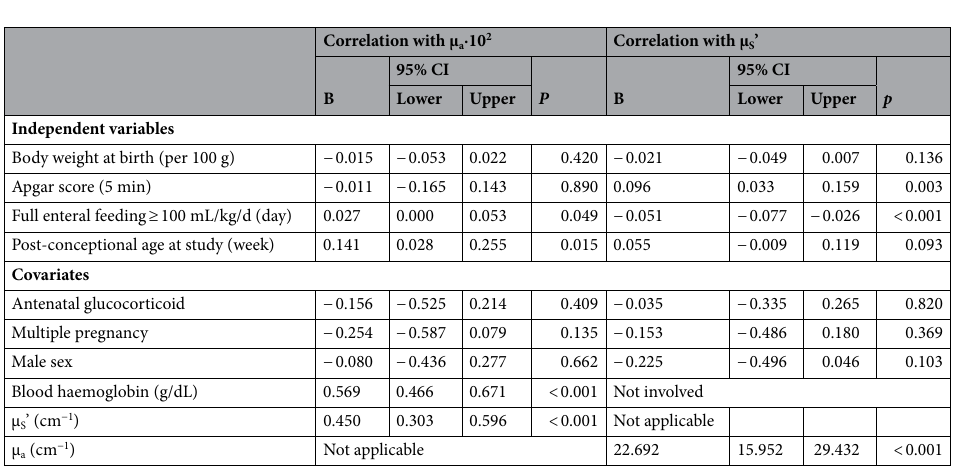
Figure 2. Dependence of μ S ’ on µ a in four head regions. Scatter plots demonstrating relationships between µ a and μ S ’ obtained from the anterior ( A ), left-temporal ( B ), right-temporal ( C ) and posterior ( D ) head regions for wavelengths of 761 nm (circle), 791 nm (triangle) and 836 nm (cross). µ a , absorption coeffieicnt. μ S ’, reduced scattering coefficient.